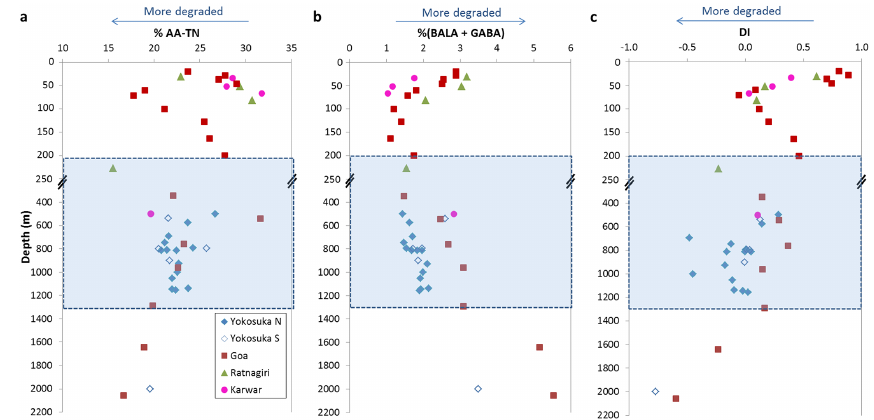
Figure 10. Plots against station depth (m) of (a) percentage of total N as hydrolysable amino acids (%AA-TN), (b) mole percentage of total hydrolysable amino acids in the form of β -alanine and γ -aminobutyric acid (%(BALA + GABA)) and (c) Degradation Index (DI) as per Dauwe and Middelburg (1998), Dauwe et al. (1999), for surficial shelf and slope sediments. Shaded area indicates the approximate depth of permanent mid-depth OMZ (< ∼